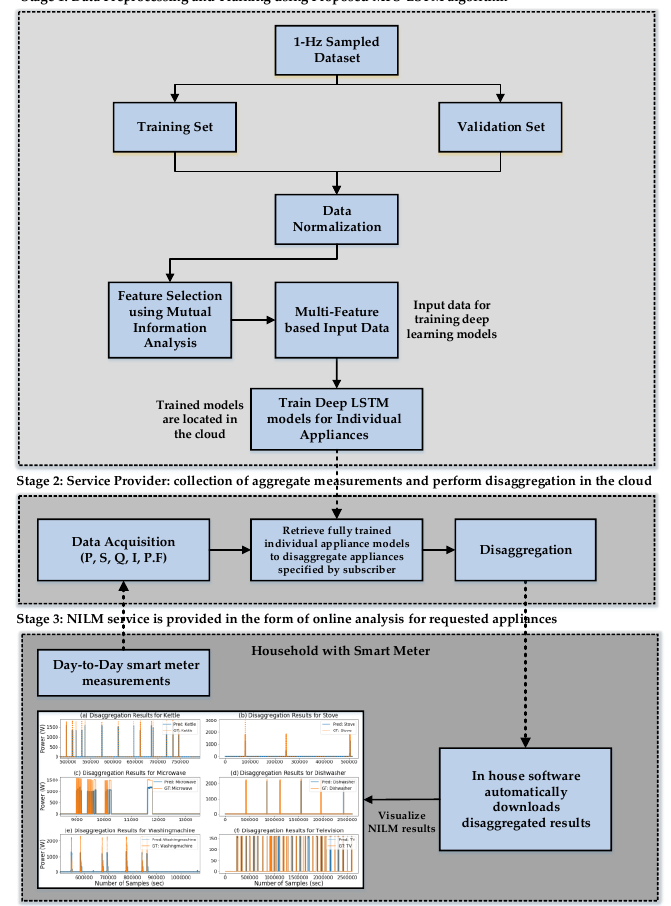
Figure 4. Real-time deployable NILM framework employing MFS-LSTM algorithm.